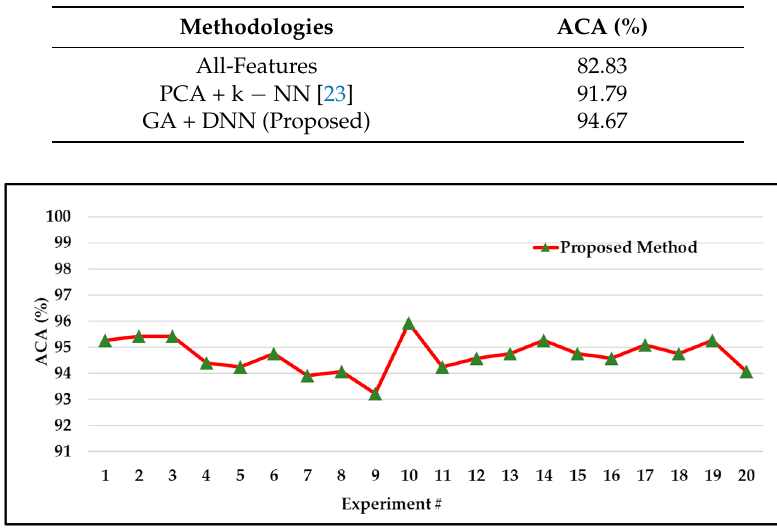
Figure 11. Classification accuracies of the proposed method achieved over 20 experiments.